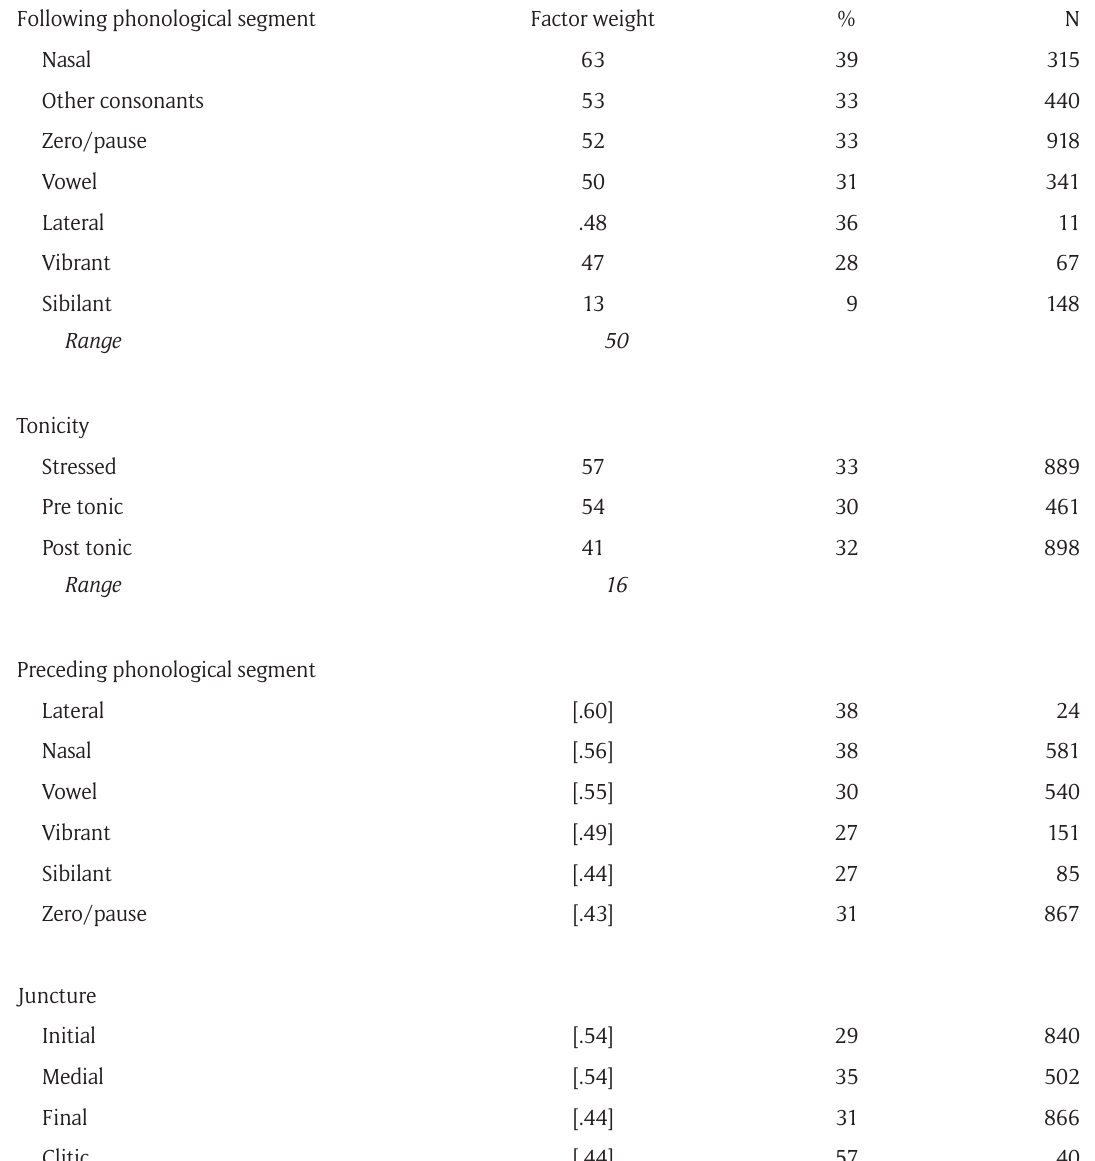
Table 11: Variable rule analyses of the contribution of linguistic factors selected as significant to the prob- ability of palatalization of /ti/, /di/ in UP (1995 data). Note : Factor groups not selected as significant appear in square brackets (adapted from Carvalho,